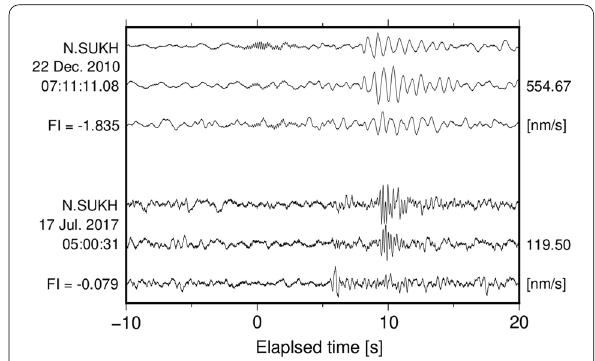
Fig. 4 Waveform examples of DLF earthquakes. Top three component waveforms show an DLF earthquakes in 2010 with the low FI value (FI 1.835). Bottom three component = − waveforms show an DLF earthquakes in 2017 with the high FI value (FI 0.079). These waveforms were normalized by the maximum = − value written on the right side of the box